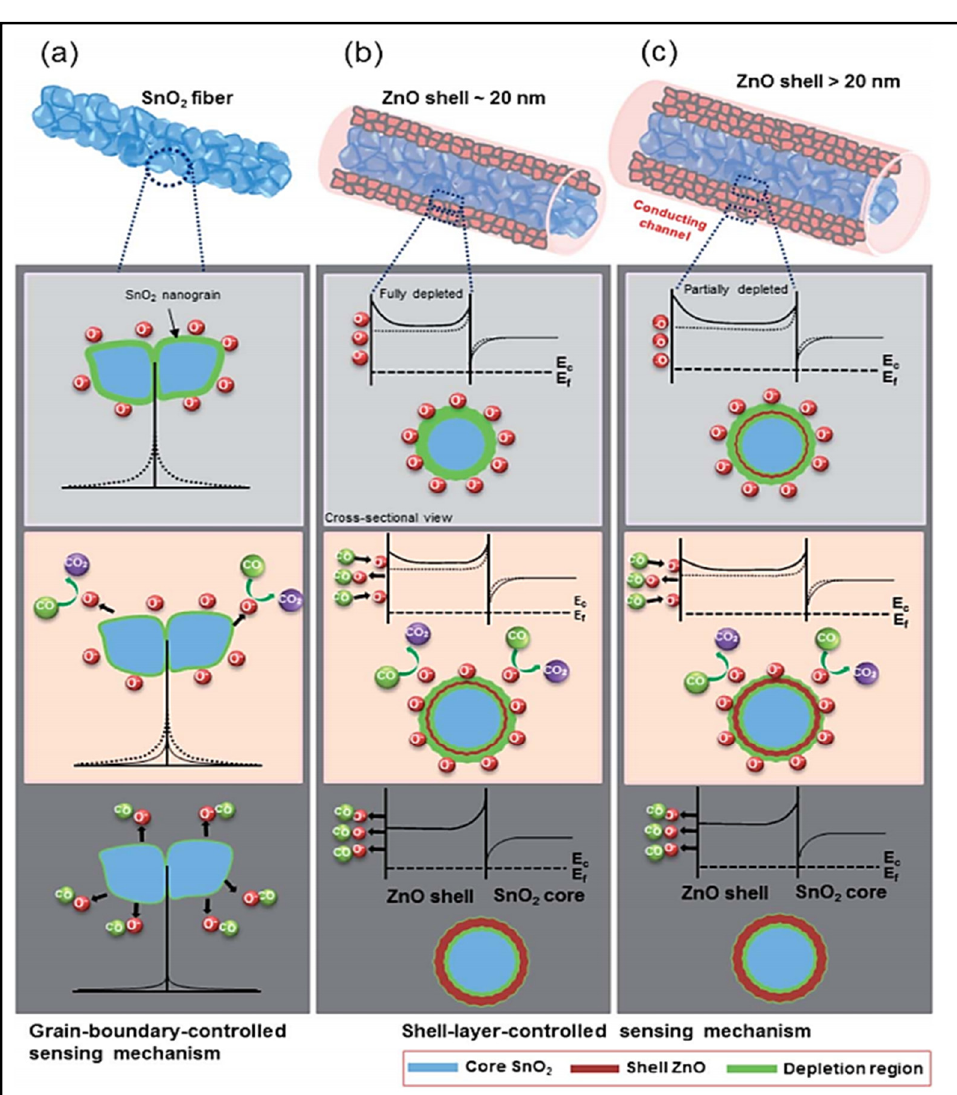
Figure 3. Schematic representation of the radial modulation of the ZnO shell layer: ( a ) pristine SnO 2 NFs and SnO 2 -ZnO C-S with a shell thickness of ( b ) λ D and ( c ) > λ D [73]. Reproduced from [73] with the permission of Royal Society of Chemistry.